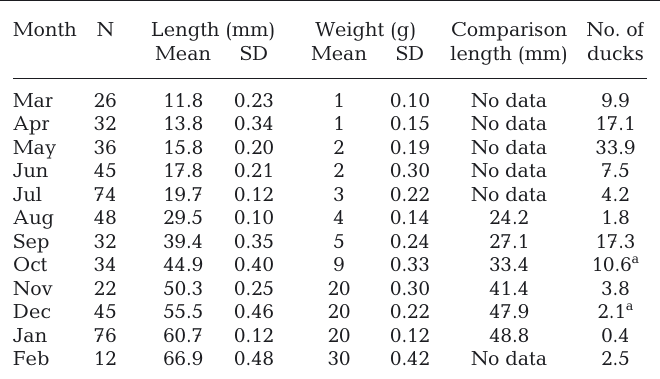
Table 1. Average length and weight of blue mussels Mytilus chilensis haphazardly collected from March 1988 to February 1989 from the rafts’ hanging ropes at no more than 50 cm depth and Magellanic steamer ducks counted at the farm in Yaldad Bay in the corresponding month. Comparison length: for comparison, first-year lengths of M. chilensis at the Yaldad farm from 1982 are shown (data from Navarro & Winter 1982). N: number